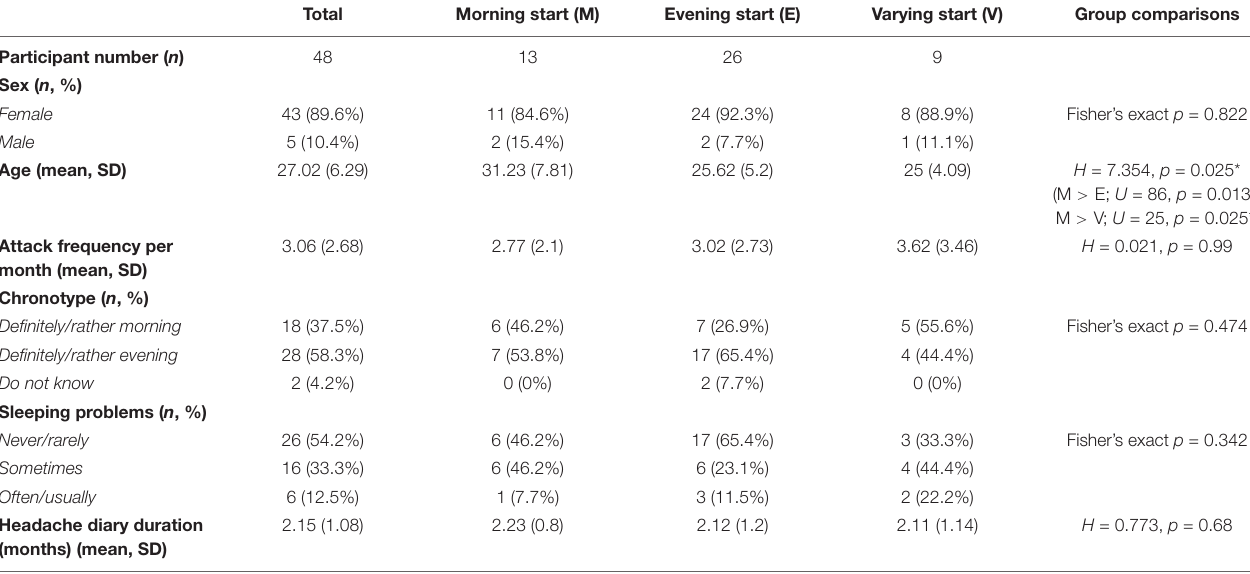
TABLE 4 | Details of the Study 2 sample and statistical results of the comparison between M circ subsamples with different typical circadian peak of attack onset. Total Morning start (M) Evening start (E) Varying start (V) Group comparisons